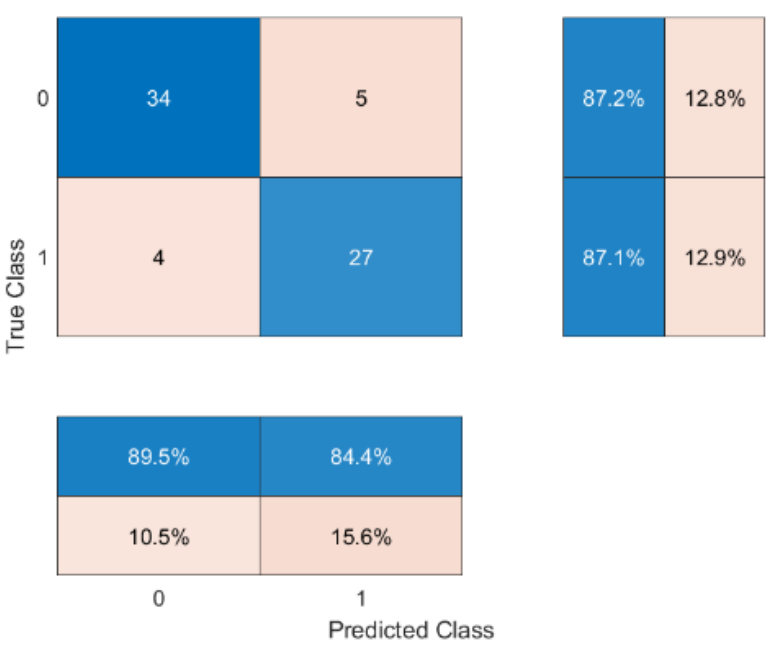
Figure 24. KNN learning results for different neural networks excluding noise level (PM10 variant).